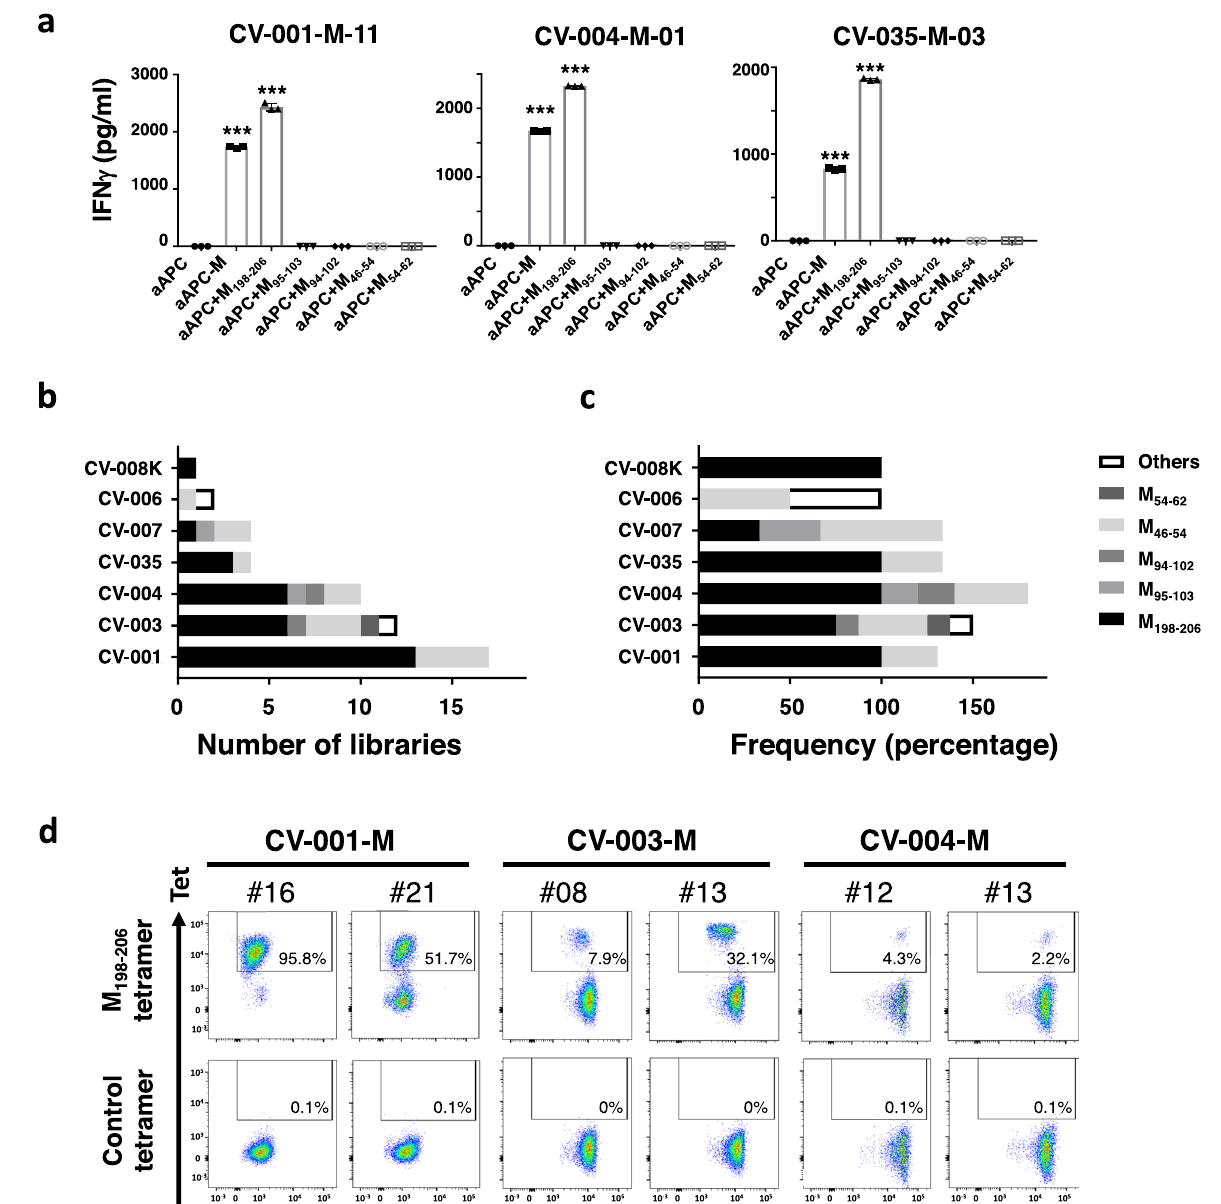
Fig. 2 | Identi fi cation of M198 – 206 as a major epitope. a Representative data fromepitopescreening.ThelibrariesshowingpositiveresponsestoSARS-CoV-2-M protein-expressing aAPC (aAPC-M) were further expanded, divided into seven groups, and co-cultured with indicated aAPCs: aAPC, aAPC-M or each peptide- pulsedaAPCs.M 198 – 206 ,M 95 – 103 ,M 94 – 102 ,M 46 – 54 andM 54-62 peptidesweretested as epitope candidates. IFN γ levels in supernatant of libraries co-cultured with indi- cated aAPCs are shown. Data represent mean+SD ( n =3 in each group). p